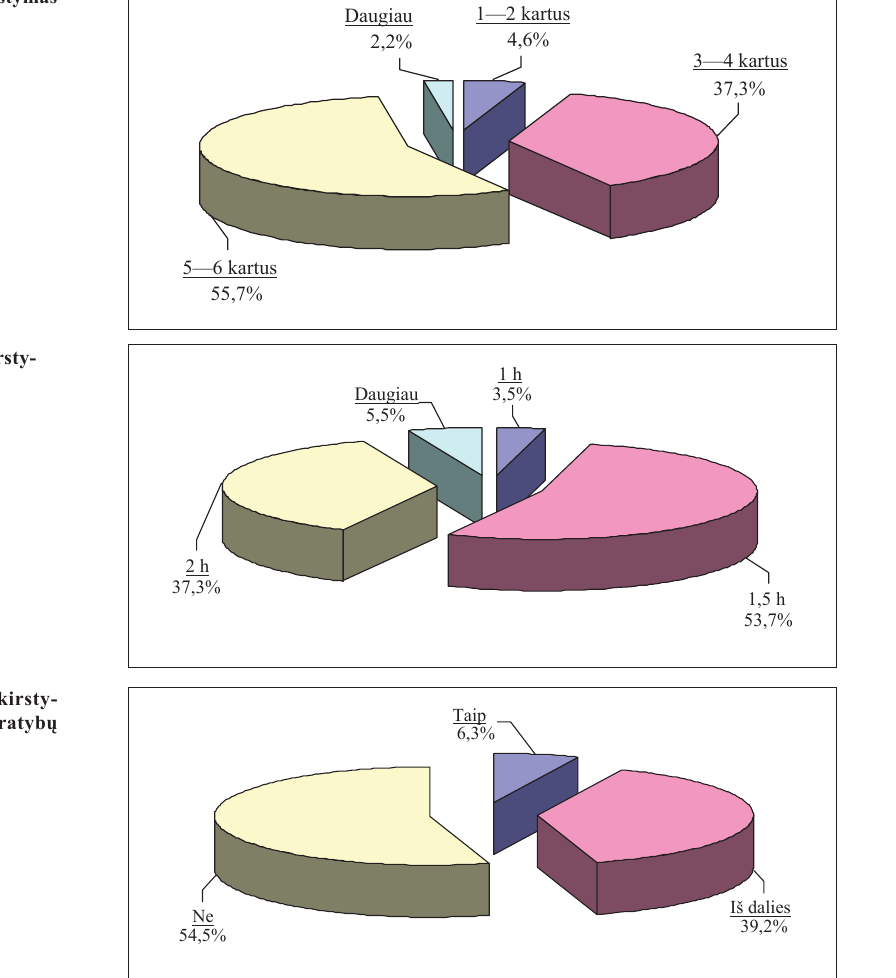
13—14 met ų (E 2 grup ė s) lengvaatle č iai daugiau treniruojasi 3—4 kartus per savait ę , 15—17 met ų (E 3 grup ė s) — 5—6 kartus, bet statistiškai pati- kimo skirtumo tarp grupi ų nenustatyta. Manome, kad per didelis procentas jaunu č i ų (53,8%) lanko pratybas 5—6 kartus per savait ę . Tai gali